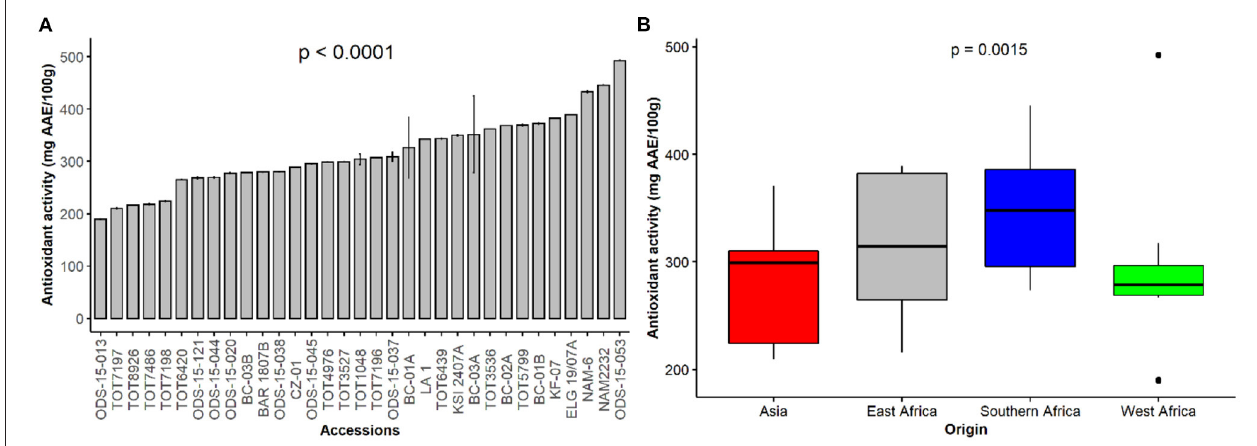
FIGURE 3 | Antioxidant activity of individual accessions (A) and based on their regions of origin (B) of a collection of 33 Gynandropsis gynandra accessions.